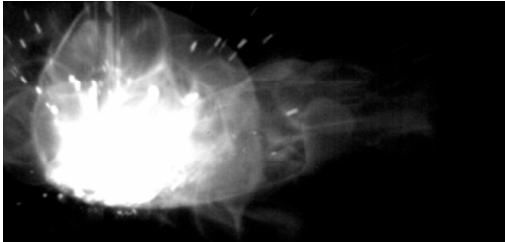
Figure 8. Incidental explosion in short-circuiting metal transfer mode [22].